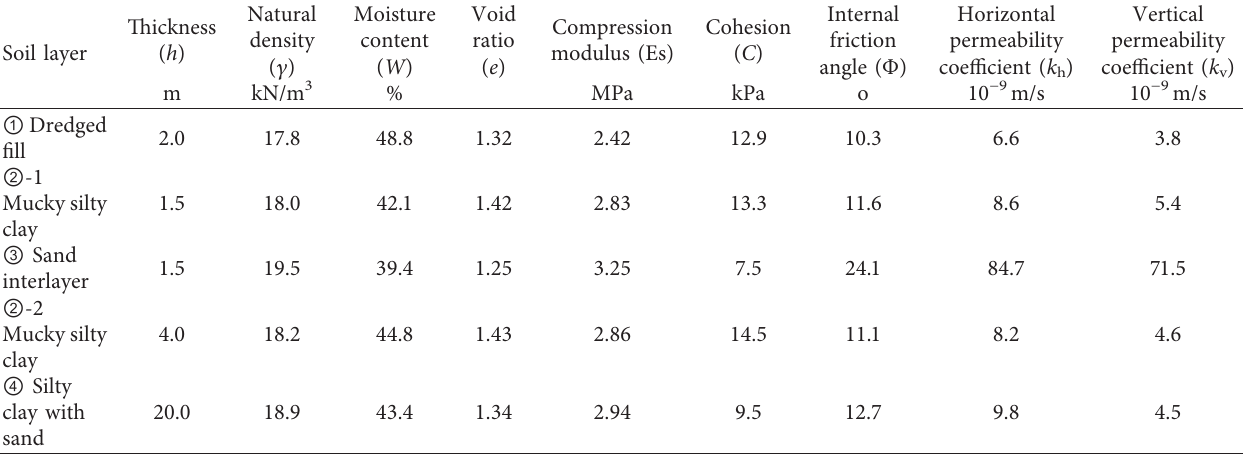
Table 1: Statistics of physical and mechanical characteristics of soil.